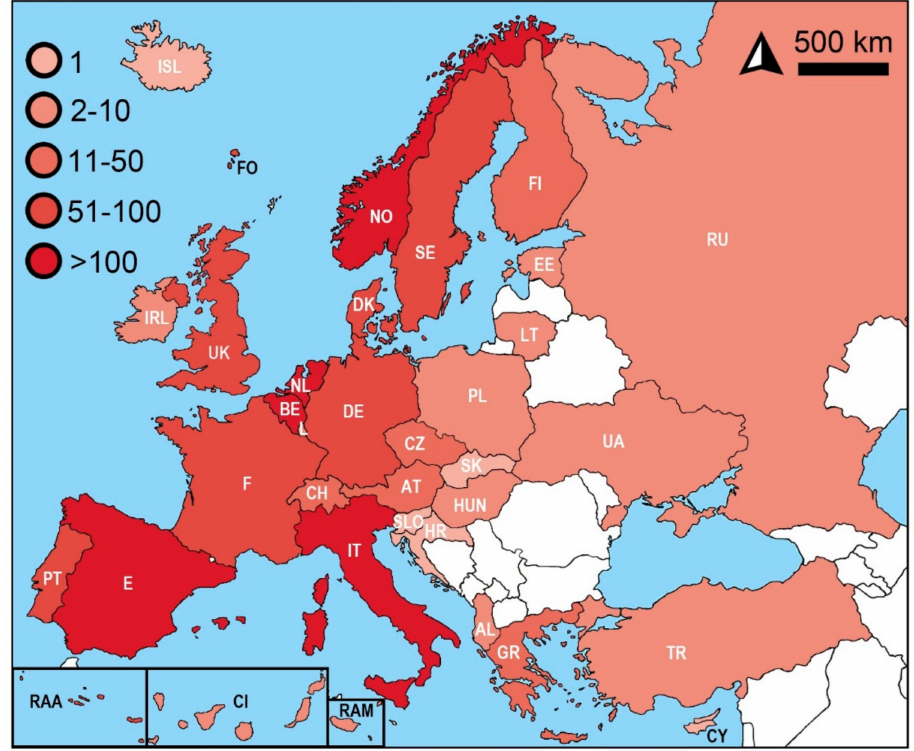
Figure 4. The abundance of Ctenolepisma longicaudatum in Europe based on citizen reports. Sources: Fauna Europea, Global Biodiversity Information Facility (GBIF), iNaturalist, Killgerm, European Net- work on Invasive Alien Species (NOBANIS), Observation.org, and Pan-European Species Directories Infrastructure (PESI); “What’s Eating Your Collection”, and available literature sources (see Table